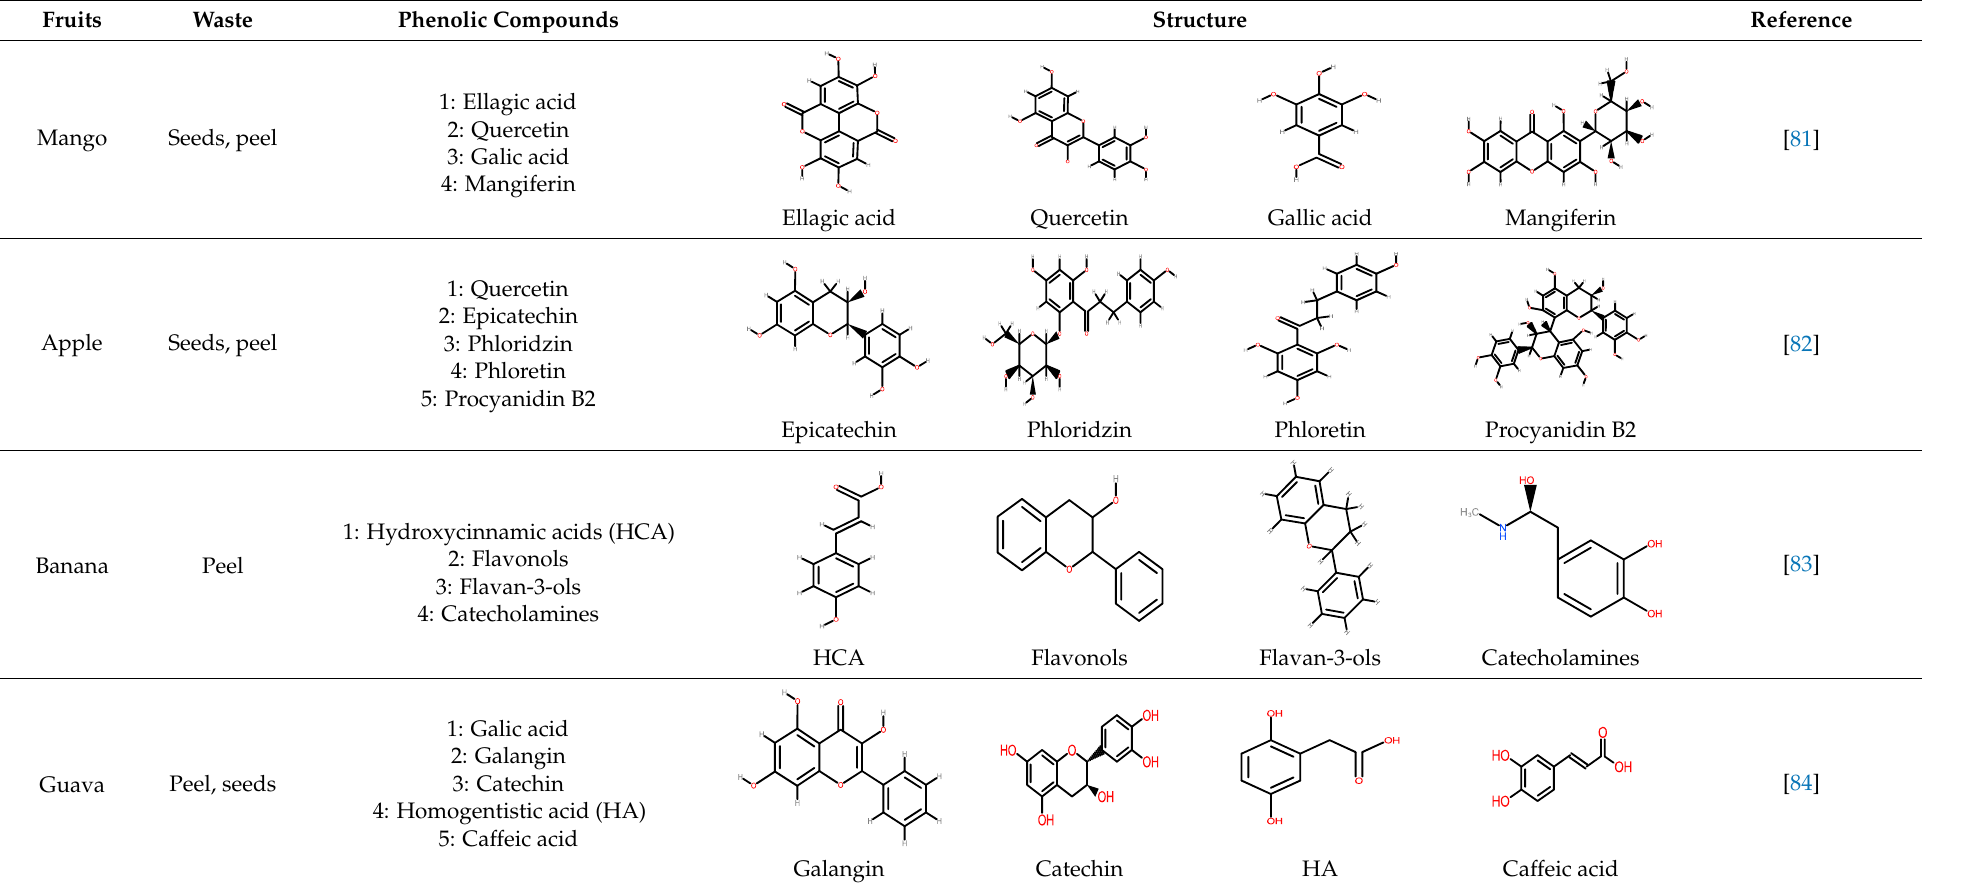
Table 3. Phenolic compounds and their structures identified in fruit waste.